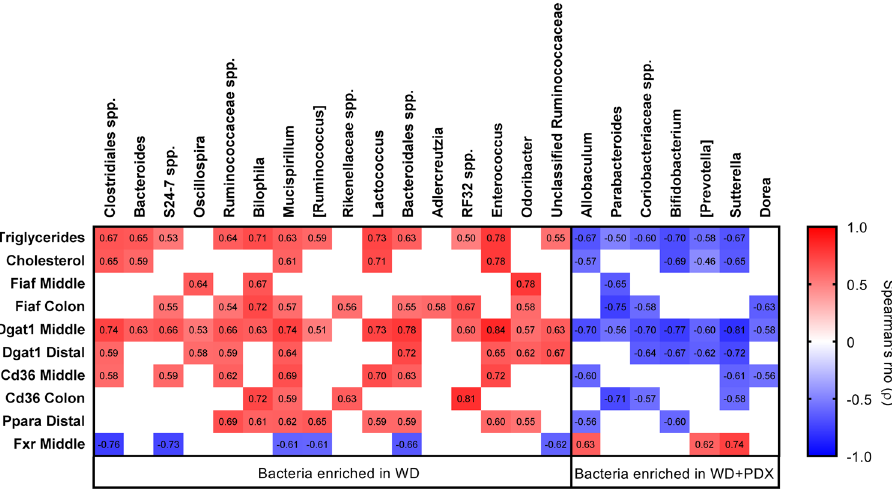
Figure 6. Spearman correlation coefficients of caecal microbial genera with lipid parameters and gene expression. Square brackets indicate the Greengenes database notation for proposed taxonomy. Only correlations that were significant after false discovery rate correction are shown, p <